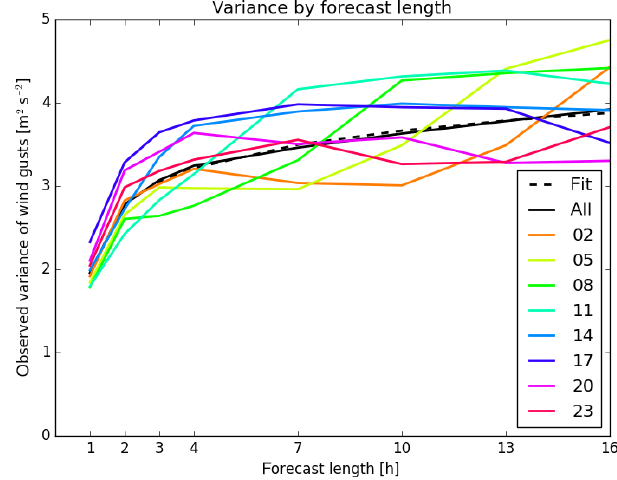
Figure 4. Distribution of wind gust observations from 2011 to 2016 for 178 synoptic stations for cases where statistical forecast (fit- ted for that period) is between 21 and 25ms − 1 . Lead time is 1h. Gaussian fit and mean of observations (green) and mean of fore- casts (red).